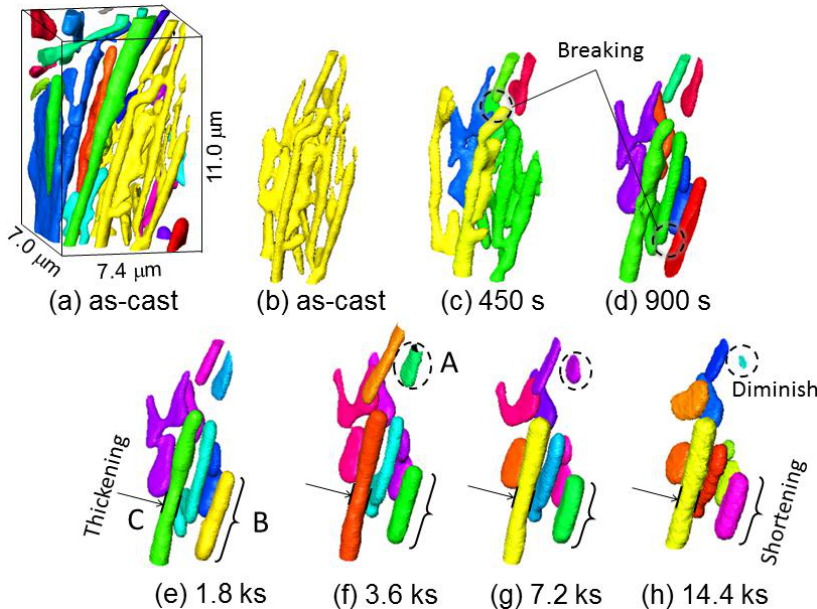
Figure 11. Magnification of three-dimensional volume image, illustrating morphology changes of Si- particles in Al-9.8%Si-3ppmP cast alloy. ( a ) as-cast, ( b ) as-cast (one particle), ( c ) heat-treated at 773 K for 450 s, ( d ) heat-treated at 773 K for 900 s. ( e ) heat-treated at 773 K for 1.8 ks. ( f ) heat-treated at 773 K for 3.6 ks, ( g ) heat-treated at 773 K for 7.2 ks, ( h ) heat-treated at 773 K for 14.4 ks.